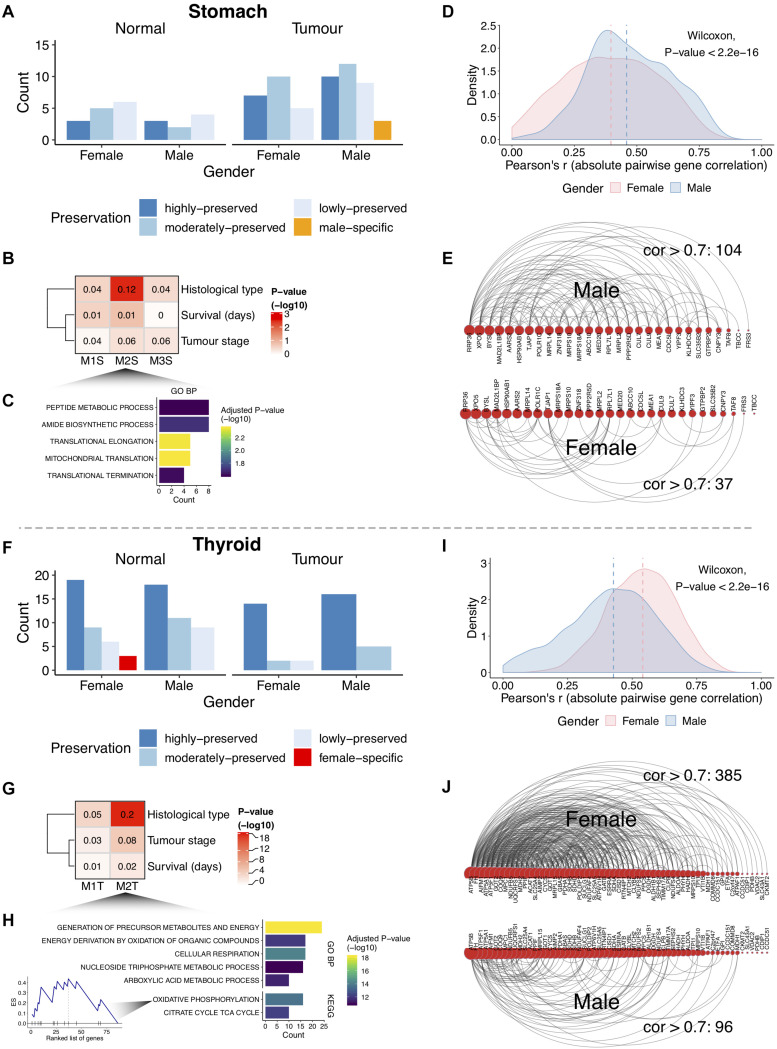
Gender differential co-expression network analysis. (A,F) Number of modules in stomach and thyroid tissues. (B,G) Association between the gastric cancer (GC) male-specific modules and the thyroid cancer (TC) female lowly preserved (in males) modules with cancer clinical traits. The numbers inside the heat maps are regression-derived R2. The one-way ANOVA-derived P-value is shown (–log10). Associations with survival were also tested using Cox hazard regressions (log-rank P-values > 5%). (C,H) Gene Ontology (GO) biological processes (GO BPs) and Kyoto Encyclopedia of Genes and Genomes (KEGG) pathways enriched in the GC M2S module and the TC M2T module [top 5; false discovery rate (FDR) < 5%]. Enrichment score (ES) for the oxidative phosphorylation pathway in M2T is highlighted, with genes sorted by intra-modular connectivity degree. (D,I) Distribution of the pairwise gene correlations (absolute Pearson’s r) for all gene pairs in M2S and M2T. Vertical lines indicate medians. (E,J) Arc diagrams representing gene pair correlations for M2S (29 genes from 45) and M2T (61 genes from 86). Arcs represent gene pair correlations >0.7. Genes are sorted by number of connections. The gene pairs with correlations >0.7 were selected in the gender where the module shows specificity (males in M2S and females in M2T). The number of correlations >0.7 decreases in the opposite gender.